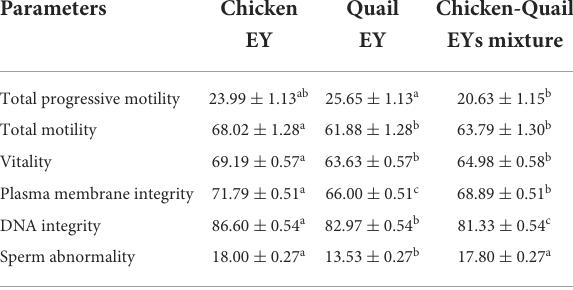
TABLE 6 Effects of adding and combining egg yolks (EY) of chicken and/or quail to the Tris glycerol extender on morphometry of ram sperm